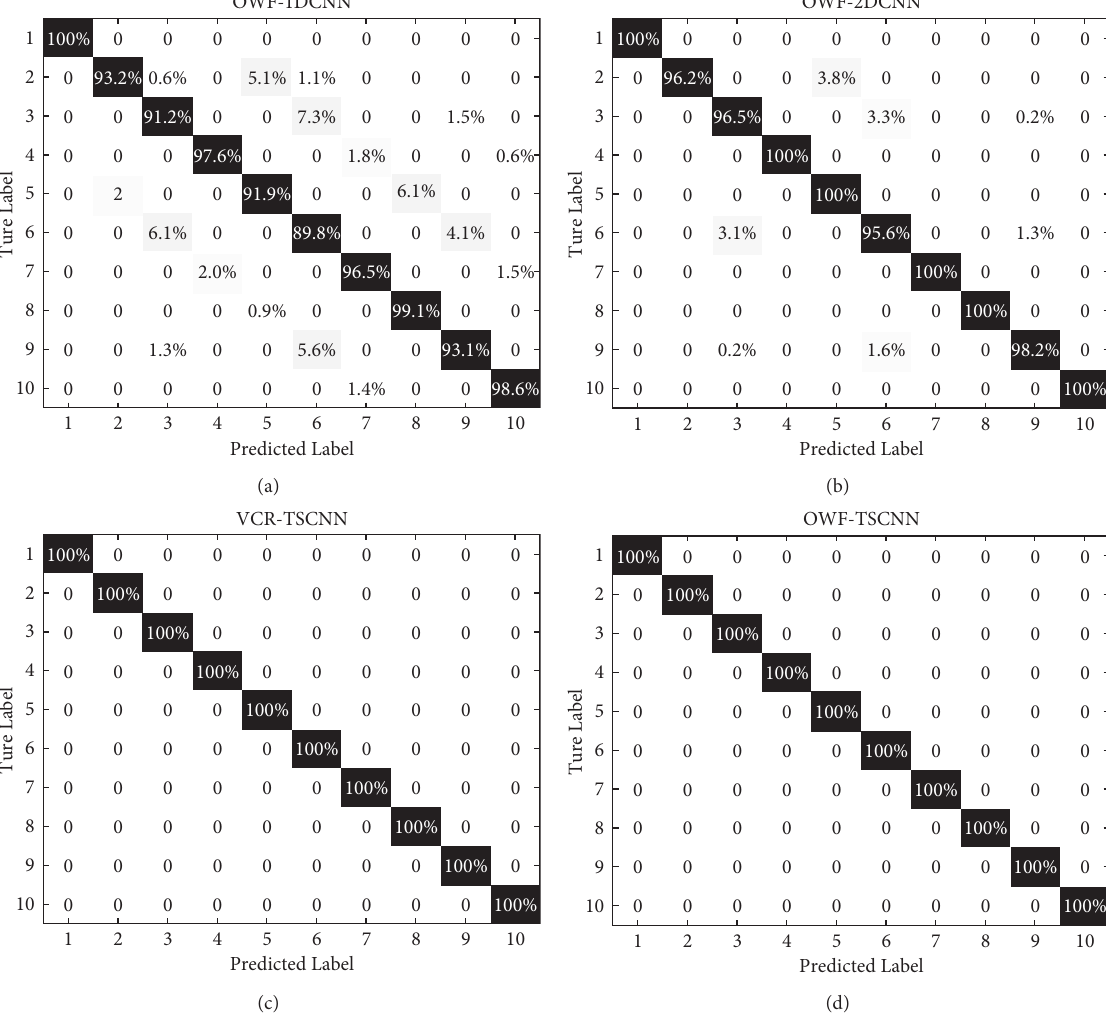
Figure 10: Confusion matrix of defect classification: (a) OWF-1DCNN; (b) OWF-2DCNN; (c) VCR-TSCNN; (d)